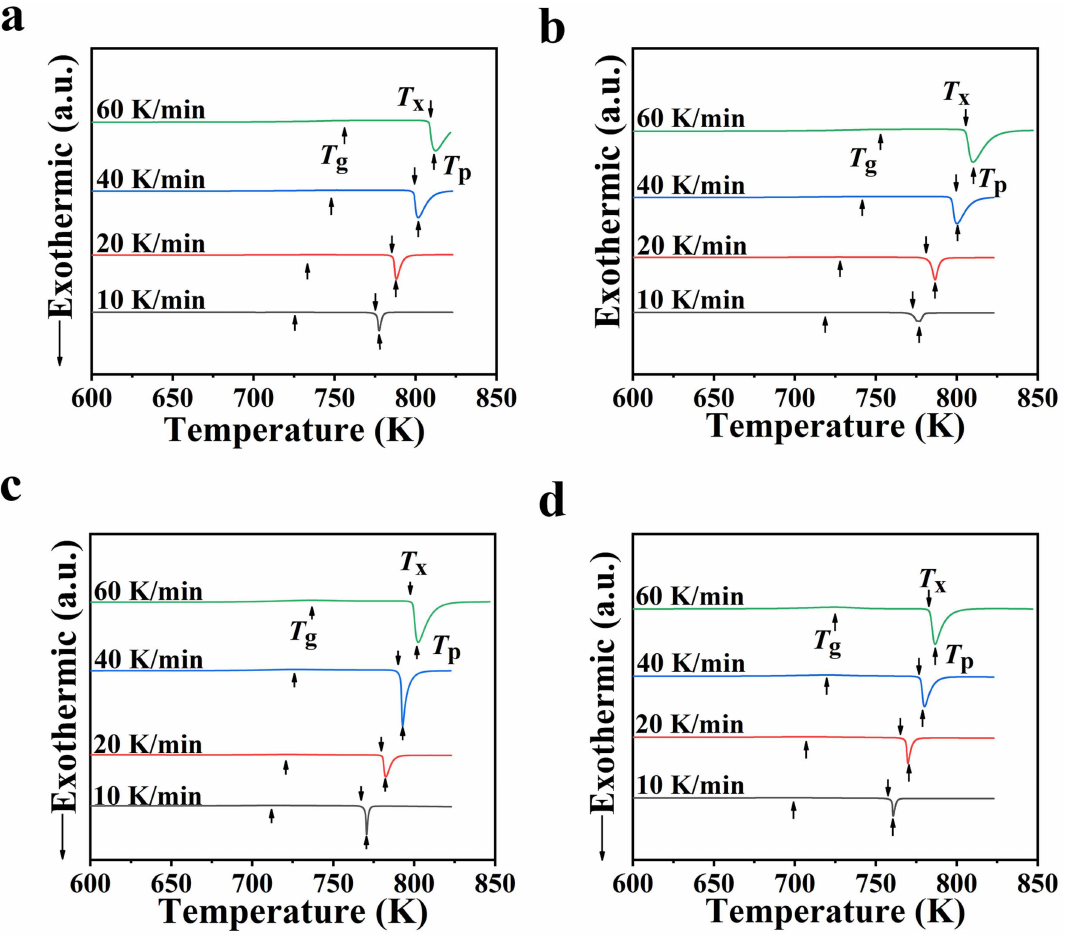
Figure 5. DSC curves of ( a ) Y0, ( b ) Y1, ( c ) Y2, and ( d ) Y3 alloys at various heating